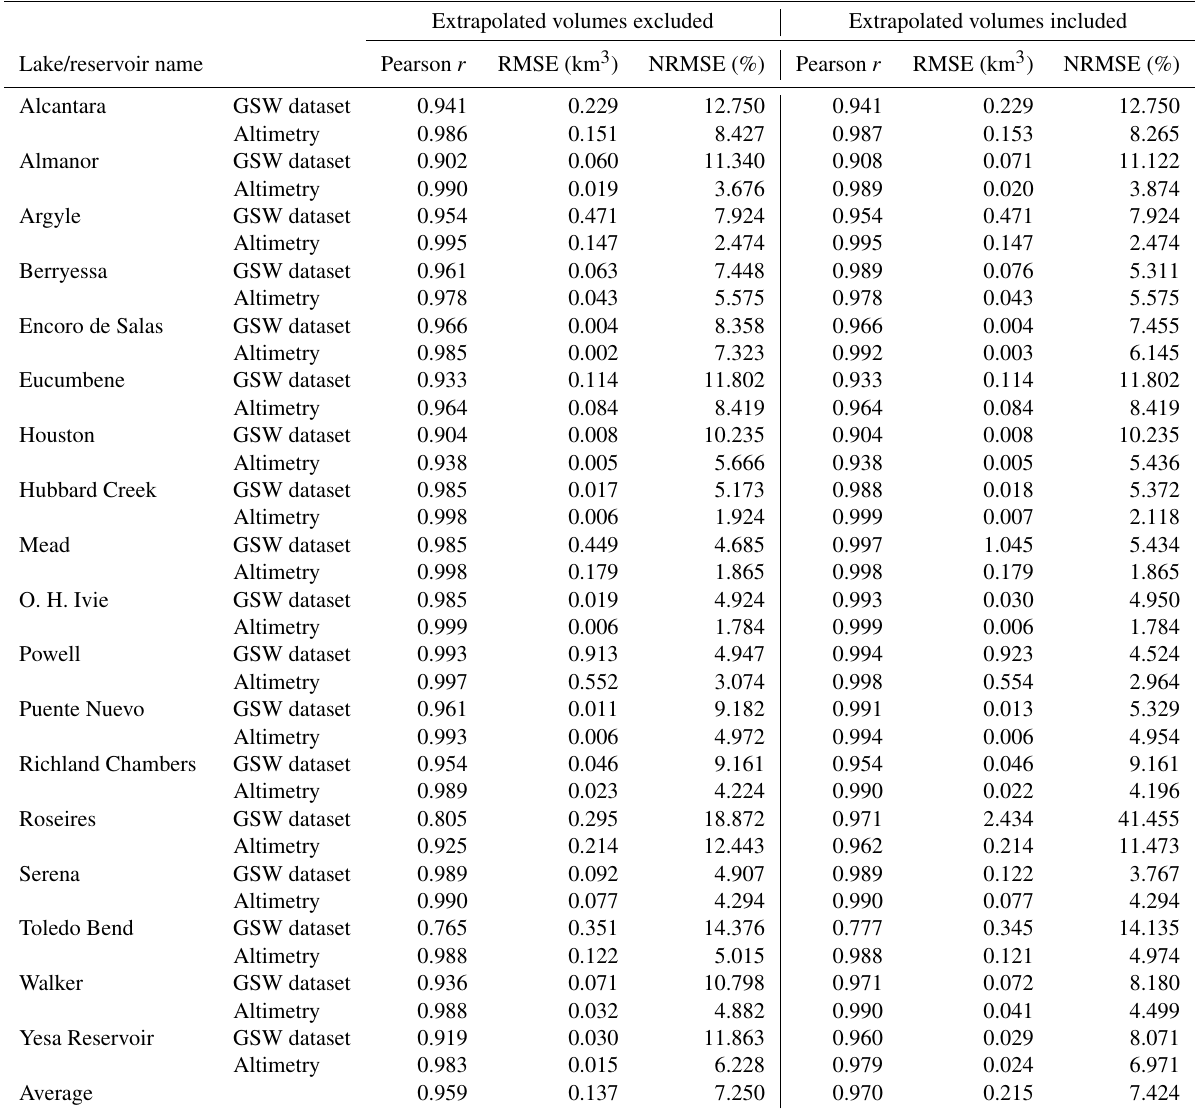
Table 1. Overview of the validation results, excluding and including extrapolated volumes. Extrapolated volumes excluded Extrapolated volumes